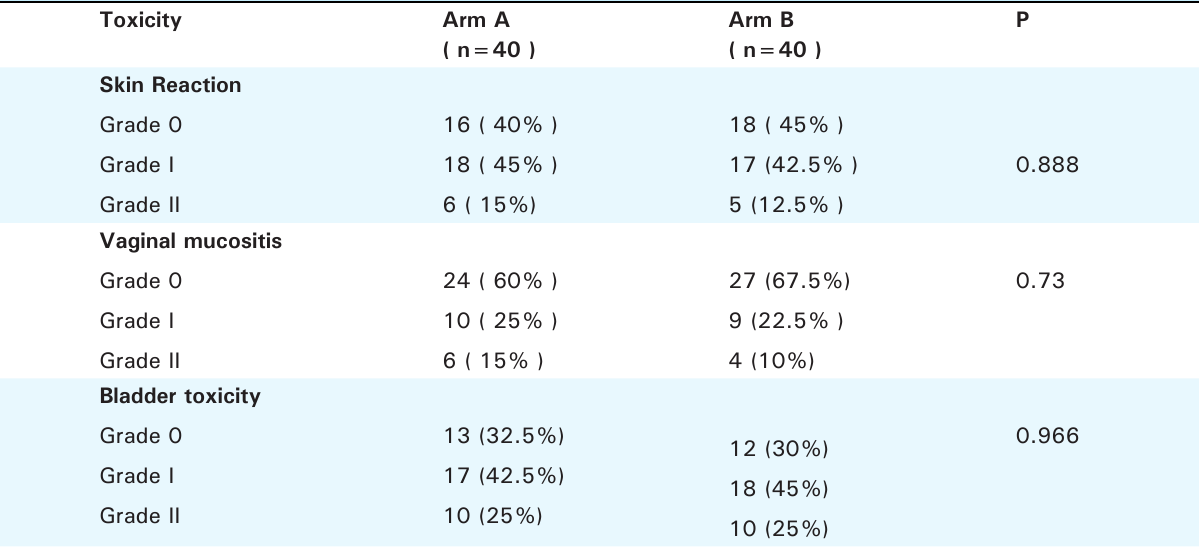
Table 3. Toxicities observed during concurrent chemotherapy along with